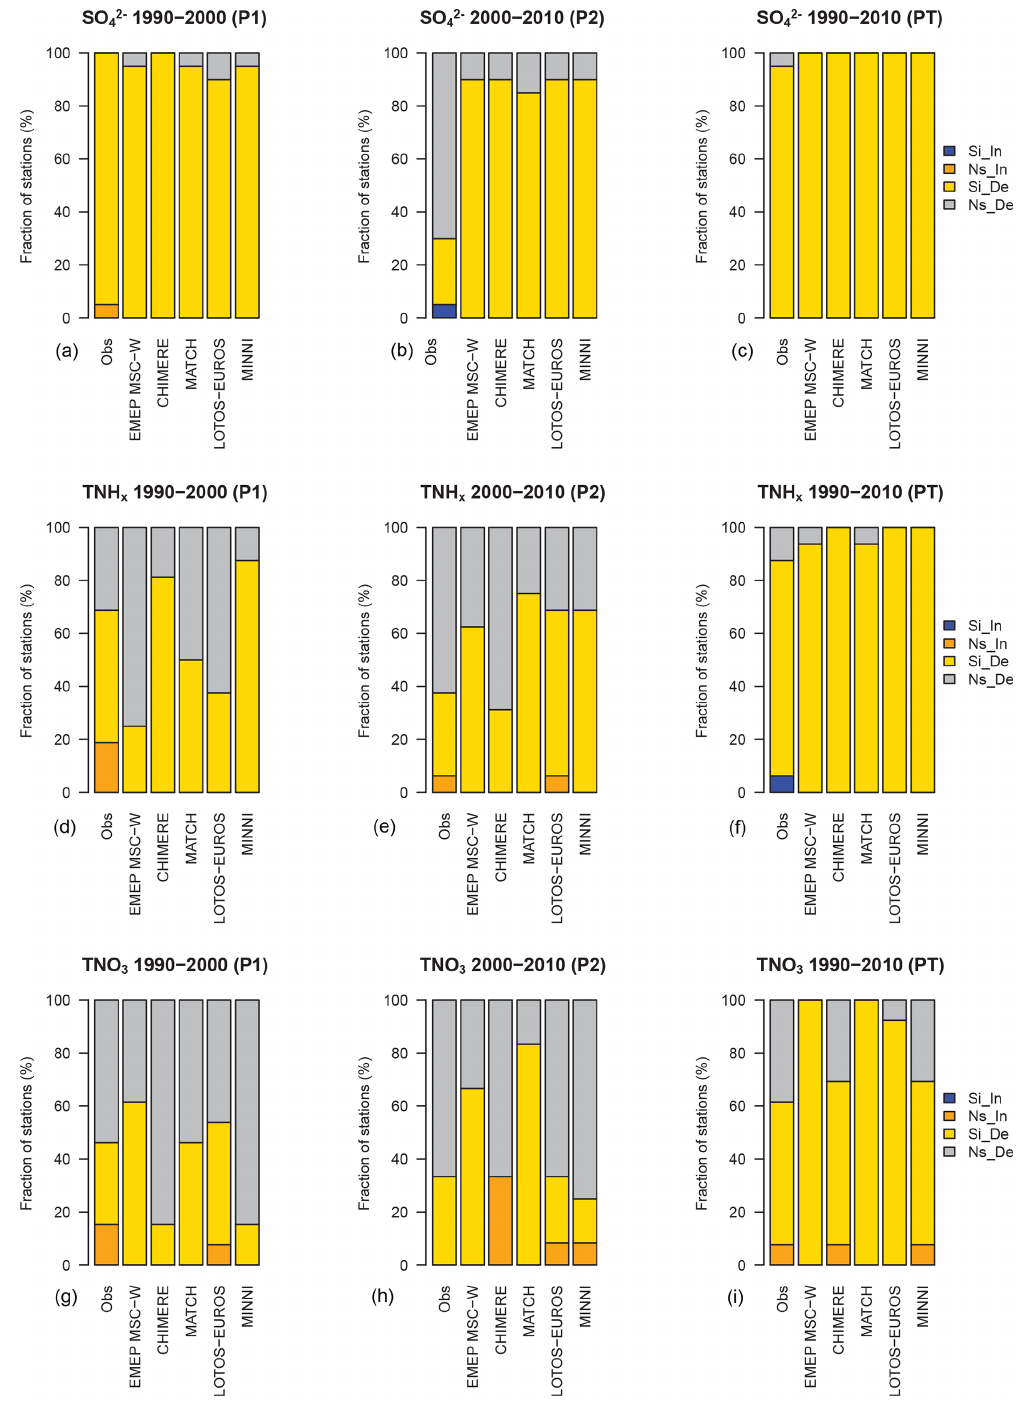
Figure 8. Percentage of statistically significant/non-significant (Si, Ns) increasing/decreasing (In, De) trends in the observations and modeled (a–c) , TNH x (d–f) and TNO 3 (g–i) for the P1 (1990–2000), P2 (2000–2010) and PT (1990–2010) periods (from left to right). data for SO 2 − 4 The number observational sites are 20, 13, 16 for SO 2 − , TNH x and TNO 3 , 4